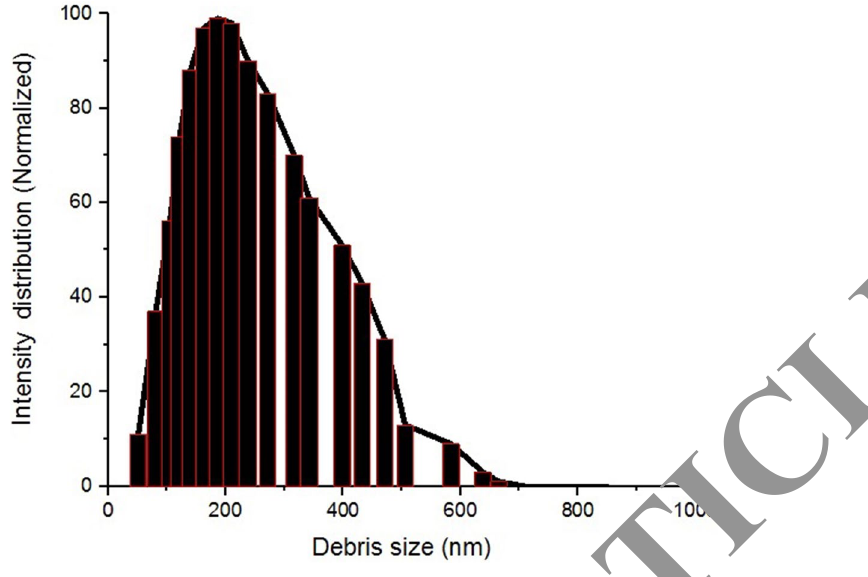
Figure 6. The size of fragments produced during the process by dynamic light scattering curves (DLS).